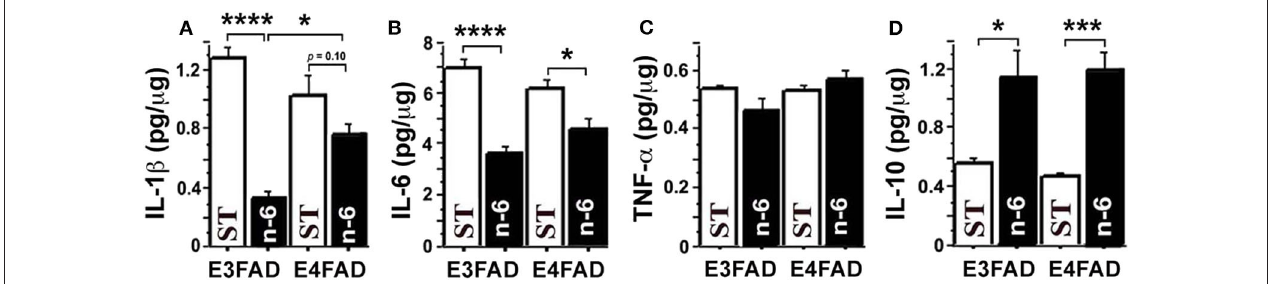
FIGURE 1 | The high n-6 linoleic acid diet reduced brain hippocampal tissue pro-inflammatory cytokines in EFAD mice. (A) High linoleic acid (n-6 or LA) diet reduced brain pro-inflammatory cytokine IL-1 β in E3FAD ( p < 0.0001) and a trend in E4FAD mice ( p = 0.1) compared to the EFAD mice on standard (ST) diet. (B) High n-6 diet reduced pro-inflammatory cytokine IL-6 in E3FAD ( p < 0.0001) and E4FAD mice (p < 0.5). (C) High n-6 diet did not change pro-inflammatory cytokine TNF- α . (D) High n-6 diet increased the inflammation-resolving cytokine IL-10 in both E3FAD ( p < 0.05) and E4FAD mice ( p < 0.001). Data represent the mean ±